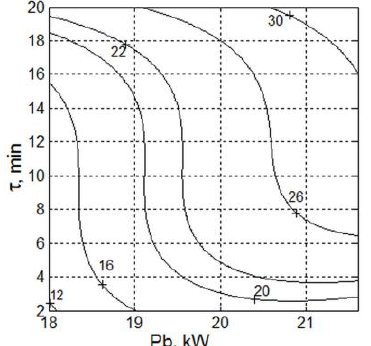
Figure 5. Contour plot of the molten pool volume V , where P b is the e-beam power and τ is the refining time.